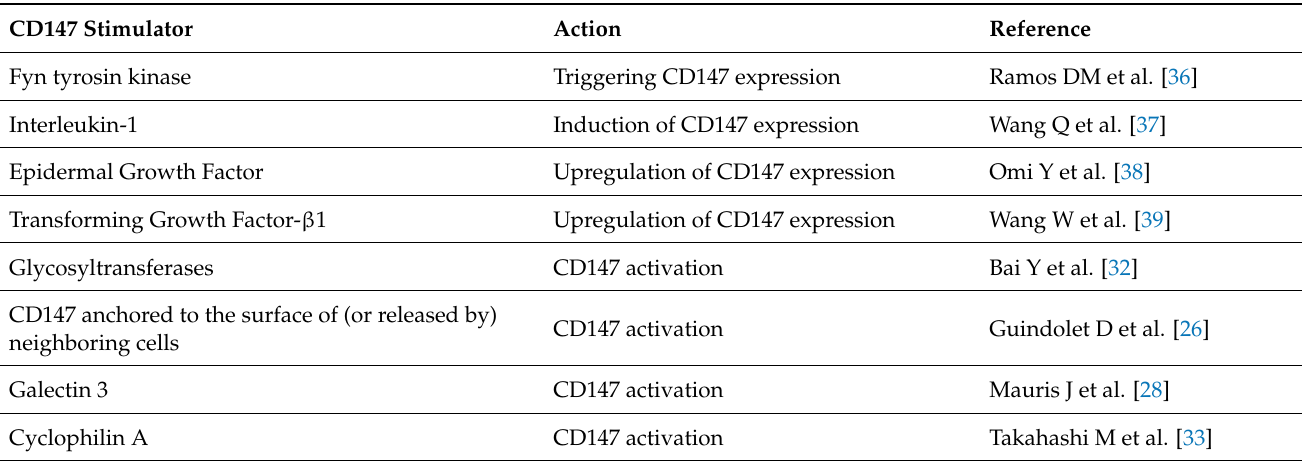
Table 1. CD147 expression and/or activity are stimulated by a wide variety of molecules, including CD147